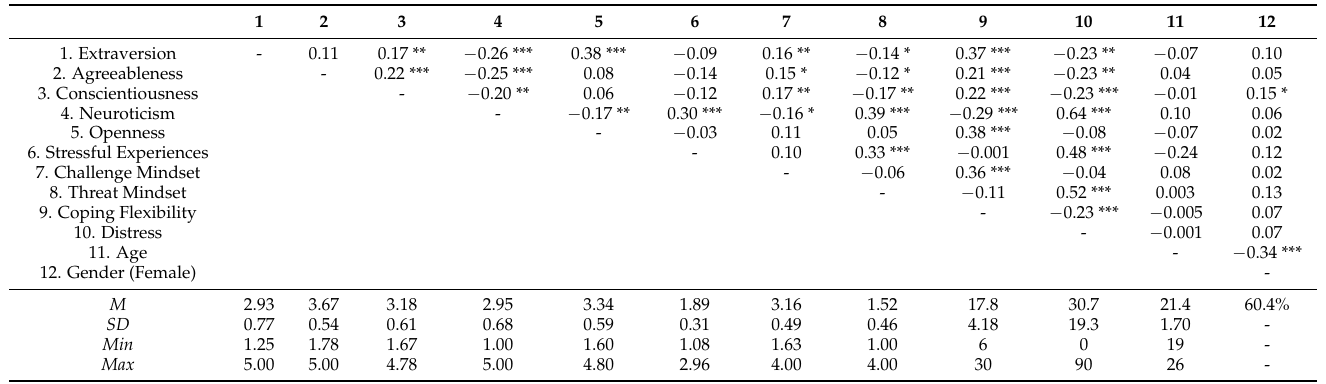
Table 1. Descriptive statistics and bivariate correlations among the main variables ( N = 260).